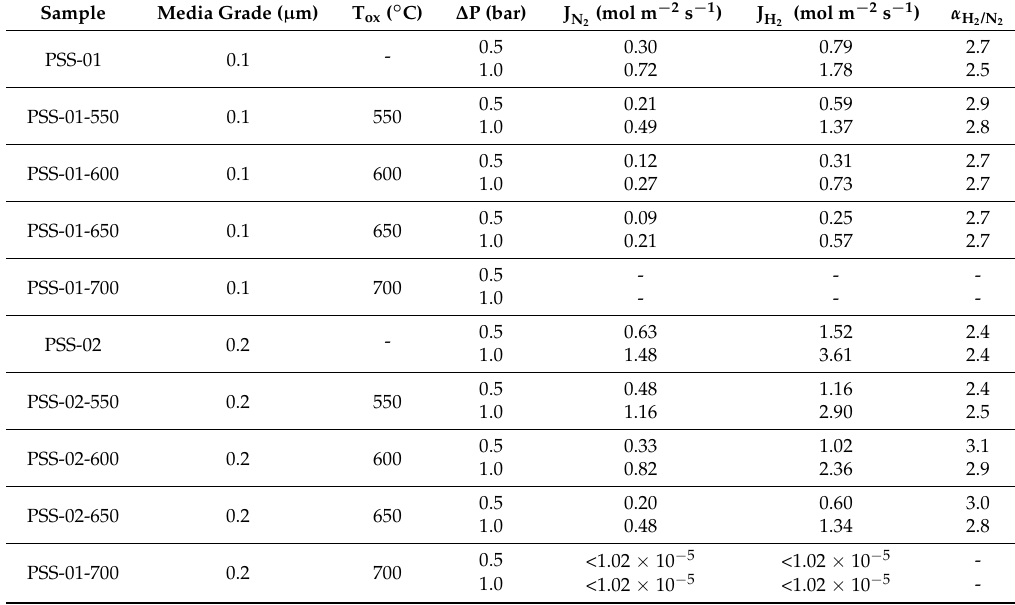
Table 2. Permeation properties of modified PSS supports after in-situ